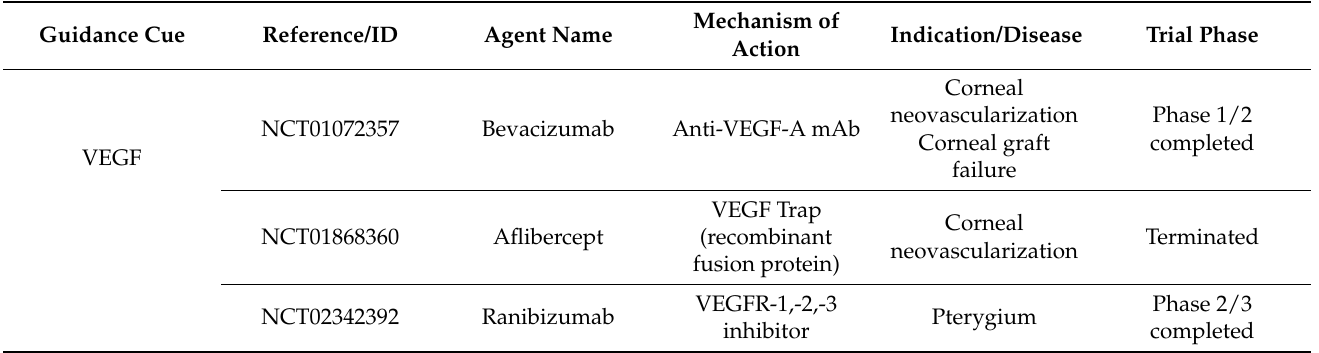
Table 3. Clinical trials involving modulators of lymphangiogenesis guidance pathways used in the